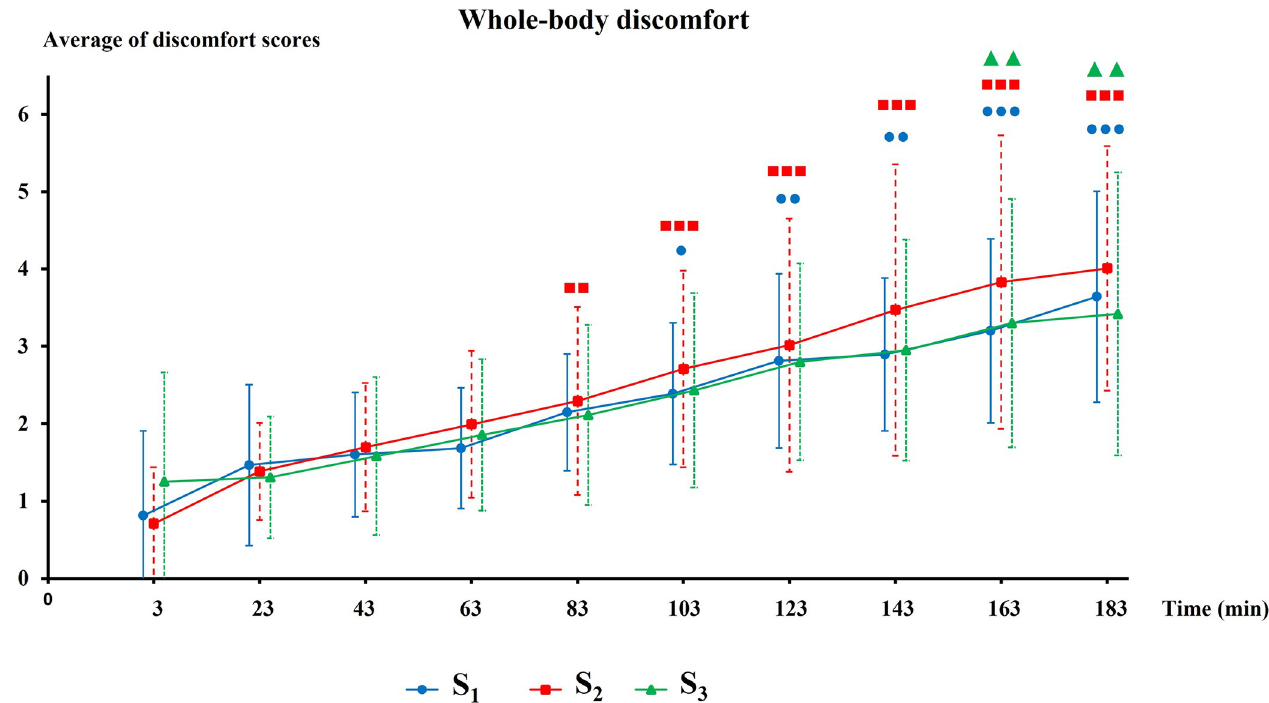
Fig 4. Evolution of whole-body discomfort during driving session. Significant level of discomfort compared to the initial value are represented by ● for S 1 ; ■ for S 2 and ▲ for S 3 (1 symbol; p < 0,05; 2 symbols: p < 0,01 & three symbols: p < 0,001).